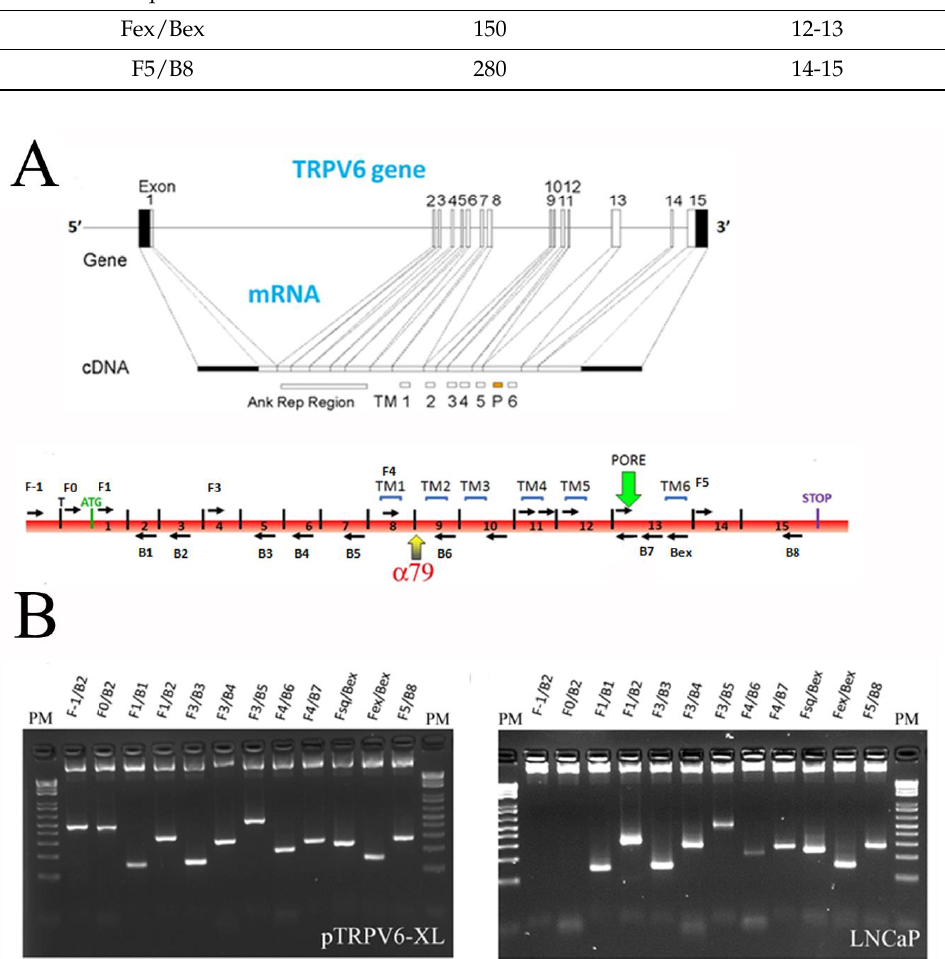
Figure 4. RNA profiling of the mRNA of the TRPV6 channel. ( A ), the general scheme of the TRPV6 gene with the relative position of the introns and exons and the final spliced mRNA of the TRPV6 gene (gene scheme from http://atlasgeneticsoncology.org/, accessed on 1 May 2009), with the position of the primers listed in Table 2 with the expected sizes and targeted exons indicated in the Table 3, the epitope of the antibody rb79, transmembrane, and pore regions. ( B ), RNA profiling using the set of primers and their expected sizes from Table 3 using the vEF1ap-5 ’ UTR-TRPV6_CMVp-mCherry vector alone (left panel) and the total cDNA from the LNCaP cells (right panel). Since the rabbit polyclonal anti-TRPV6 antibody rb79 has an extracellular epitope, we initially tried to detect the TRPV6 channel on the outer surface of the plasma membrane using confocal microscopy. Cells were fixed but not permeabilized with the saponin, allowing the exclusive staining of the plasma membrane (Figure 5A). In our experiments, two control antibodies were used: a rabbit polyclonal anti-HA epitope, having the same IgG isotype, and a rabbit polyclonal anti-TRPV6 antibody, rb80, which targets the N-terminus of the TRPV6 channel, which is inside the cell. As it can be seen from Figure 5A, rb79 is capable of staining the plasma membrane TRPV6 channels on the surface of the LNCaP cells.